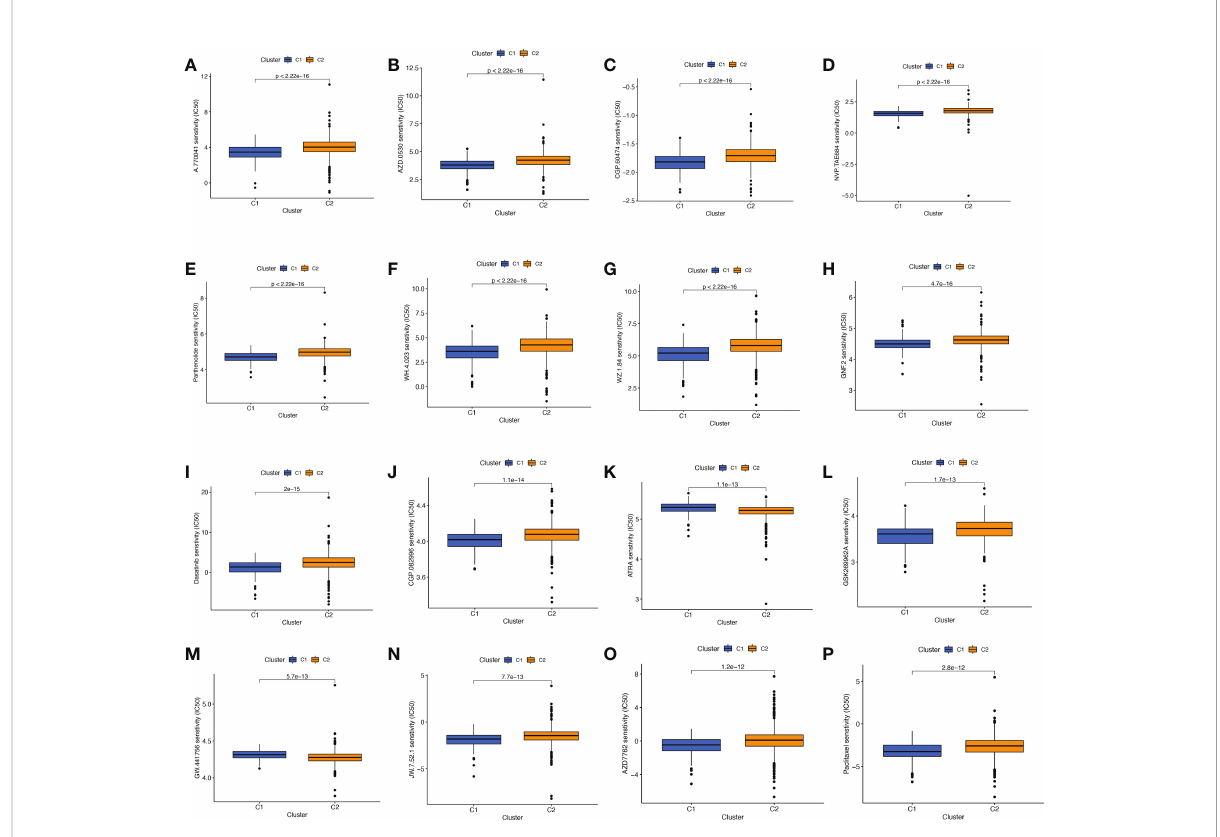
FIGURE 9 Comparison of potential therapeutic drug sensitivity between two different clusters. (A) A.770041. (B) AZD.0530. (C) CGP.60474. (D) NVP.TAE684. (E) Parthenolide. (F) WH.4.023. (G) WZ.1.84. (H) GNF.2. (I) Dasatinib. (J) CGP.082996. (K) ATRA. (L) GSK269962A. (M) GW.441756. (N) JW.7.52.1. (O) AZD. (P) Paclitaxel. The top 16 with the lowest p value were